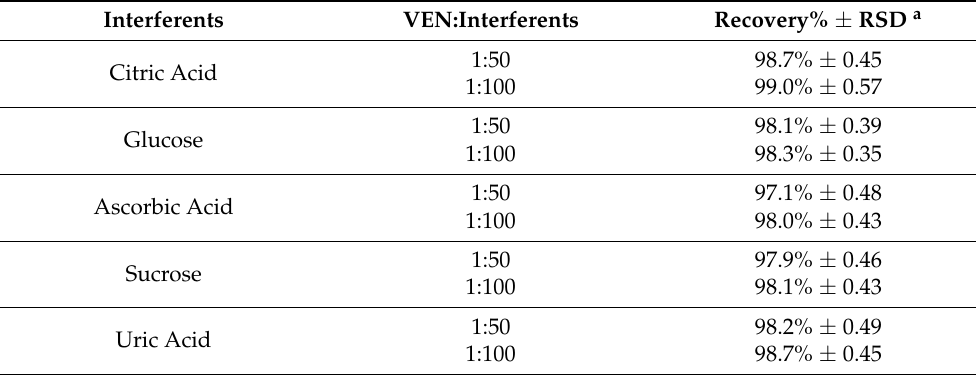
Table 2. Interference study in the presence of various interfering species commonly found in the pharmaceutical preparation of VEN.